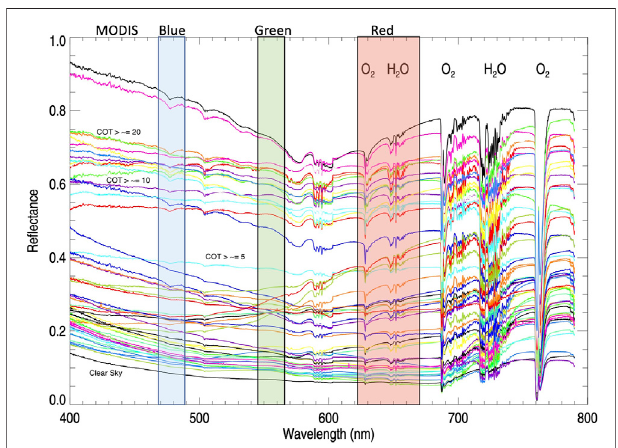
FIGURE 2 | Random sampling of GOME-2 spectra (colors chosen at random) on various days in 2018 with major atmospheric gaseous absorption bands labeled above and MODIS bands indicated as labeled above and approximate values of cloud optical thicknesses (COT) (assuming overcast conditions) and conditions (e.g., Clear Sky) labeled near the corresponding